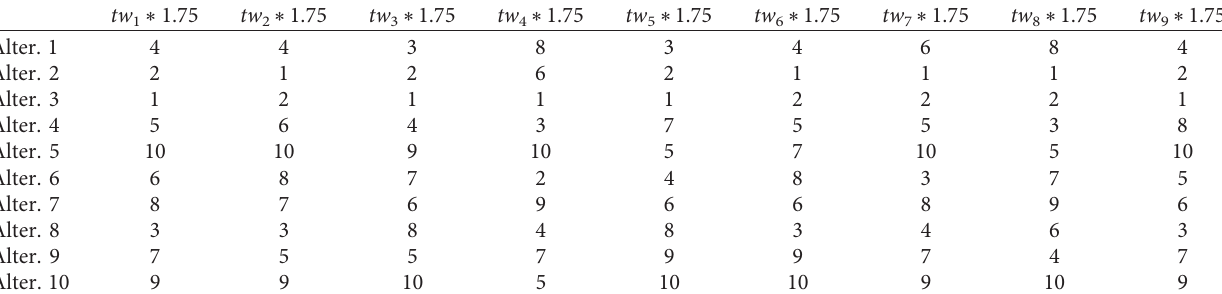
Table 27: Scenarios for the sensitivity analysis (phase I, 75%).